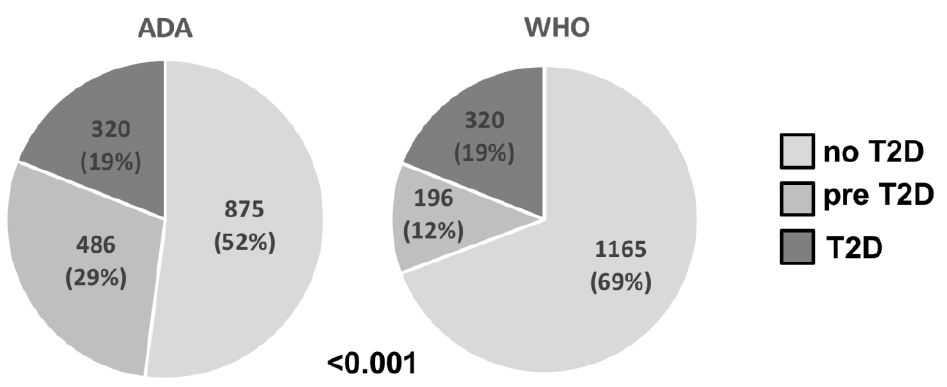
Figure 1. Prevalence of no-T2D, preT2D, and T2D according to ADA and WHO criteria.